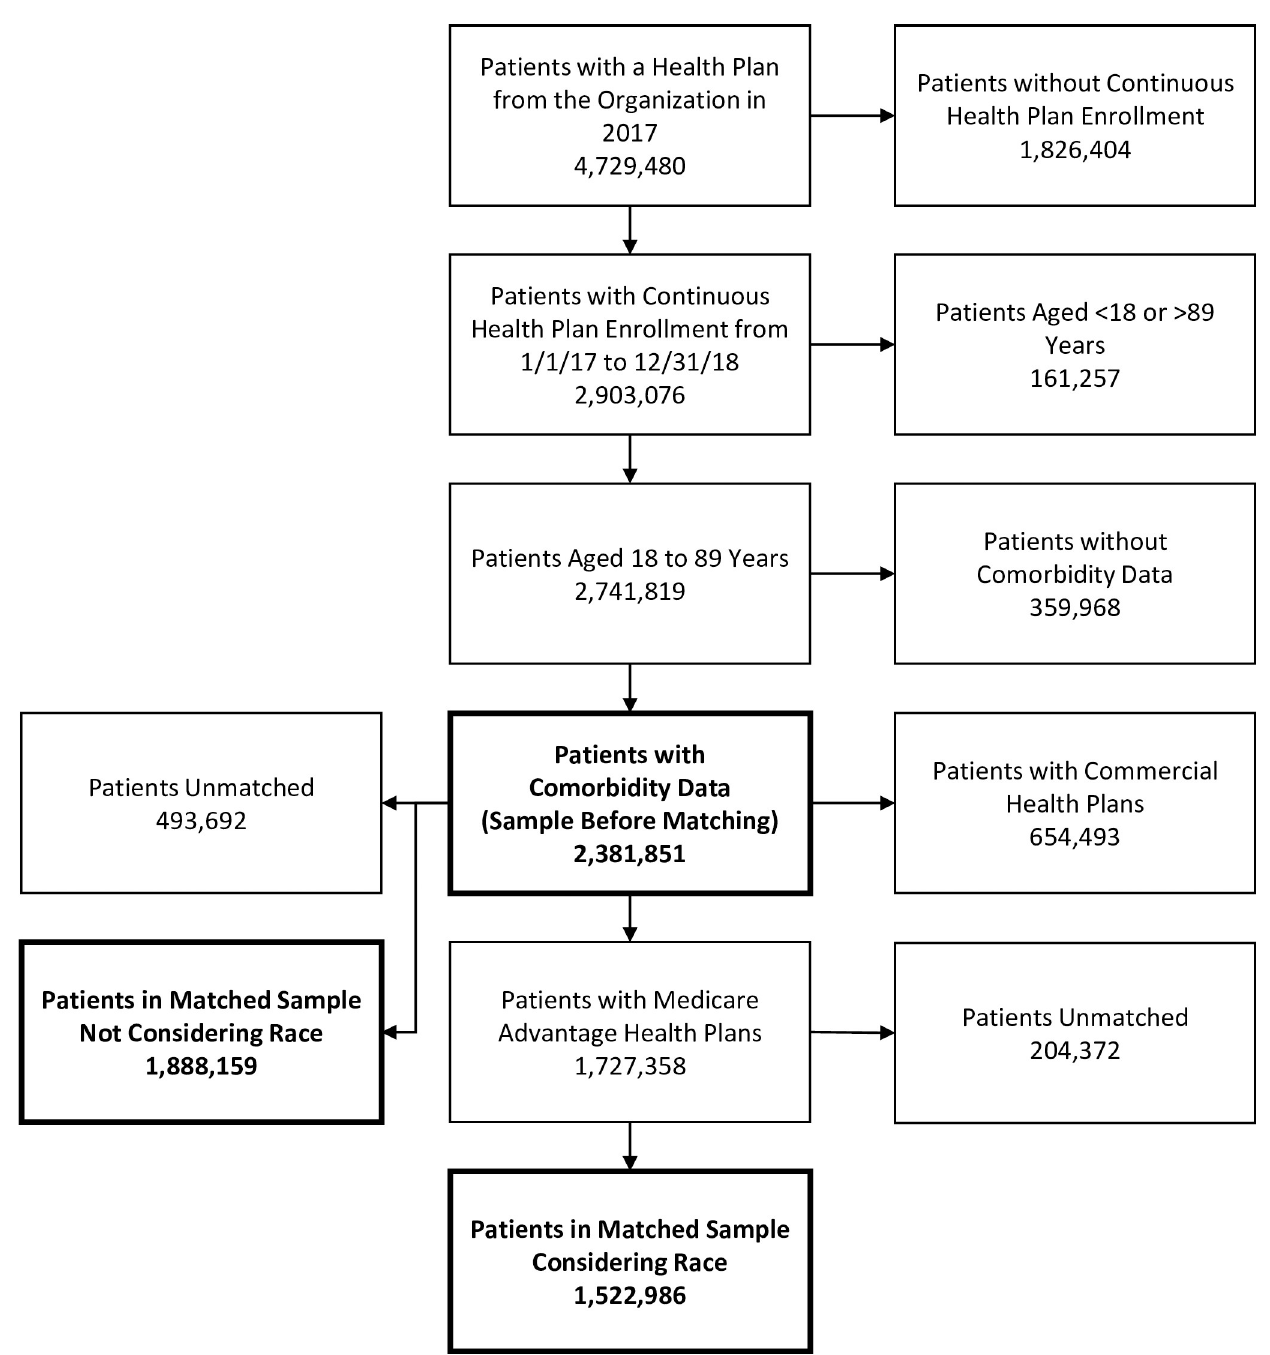
Fig 1. Participant flow